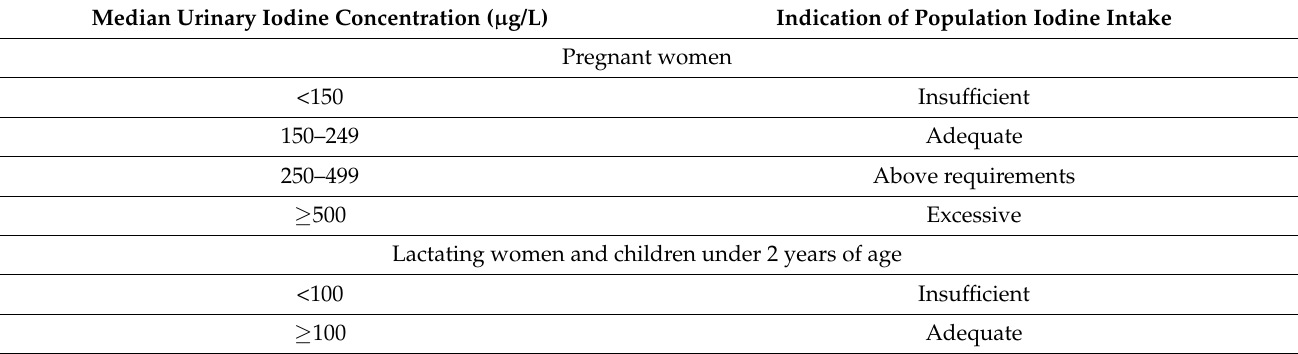
Table 3. Epidemiologic criteria for assessing population-level iodine nutrition based on median urinary iodine concentra- tions in different population groups. Median Urinary Iodine Concentration ( µ